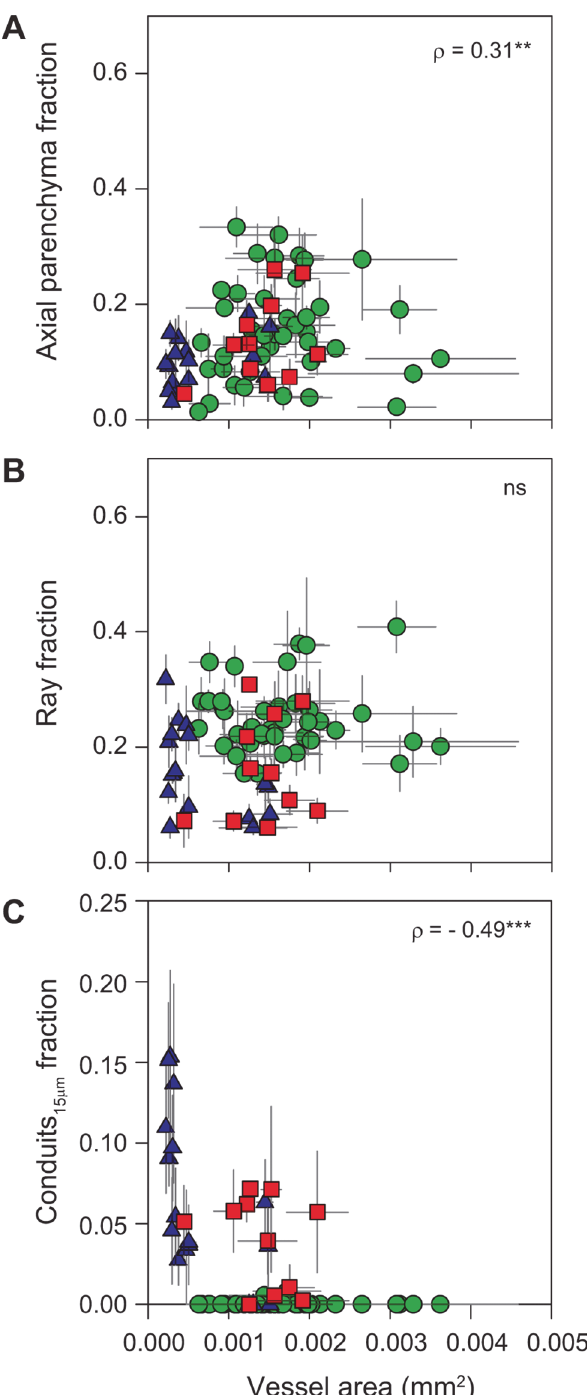
Fig 5. Relationships between axial parenchyma fraction, ray fraction, conduits 15 μ m fraction and vessel area (i.e. cross-sectional average area). Green circles — tropical rainforest (warm and wet site); red squares — tropical woodland (warm and dry site); blue triangles — temperate forest (cool and wet site). * P < 0.05, ** P < 0.01, ns — not significant.